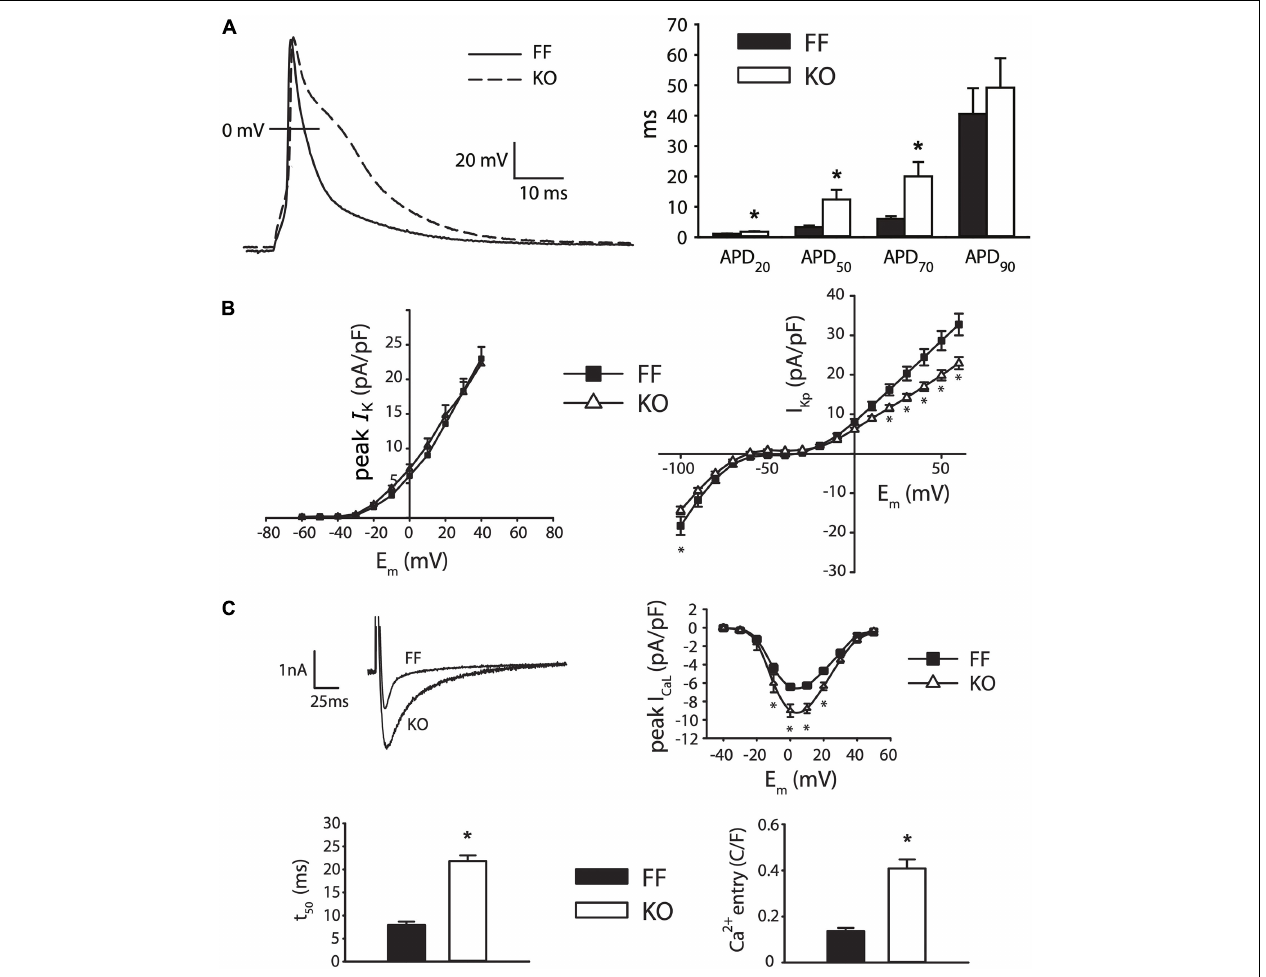
FIGURE 2 | Myocytes from failing SERCA2-KO hearts exhibit prolonged early repolarization due to exaggerated sarcolemmal calcium flux. (A) KO myocytes ( n = 10) display marked prolongation of early repolarization compared to FF ( n = 11), although this difference is normalized by 90% repolarization. (B) The dominant outward current during early repolarization ( I to ), is unaltered in the failing KO myocytes relative to FF ( n = 10, both groups; left panel), while slowly inactivating K + current components (measured as end-pulse, “pedestal” or “plateau,” K + current – I Kp ) were slightly suppressed in KO cells ( n = 17) relative to FF ( n = 20). (C) However, peak I CaL is potentiated and I CaL inactivation is dramatically slowed in KO cells ( n = 14) versus FF ( n = 12), leading to a marked increase in calcium influx. All panels: * p < 0.05. Data are means ±